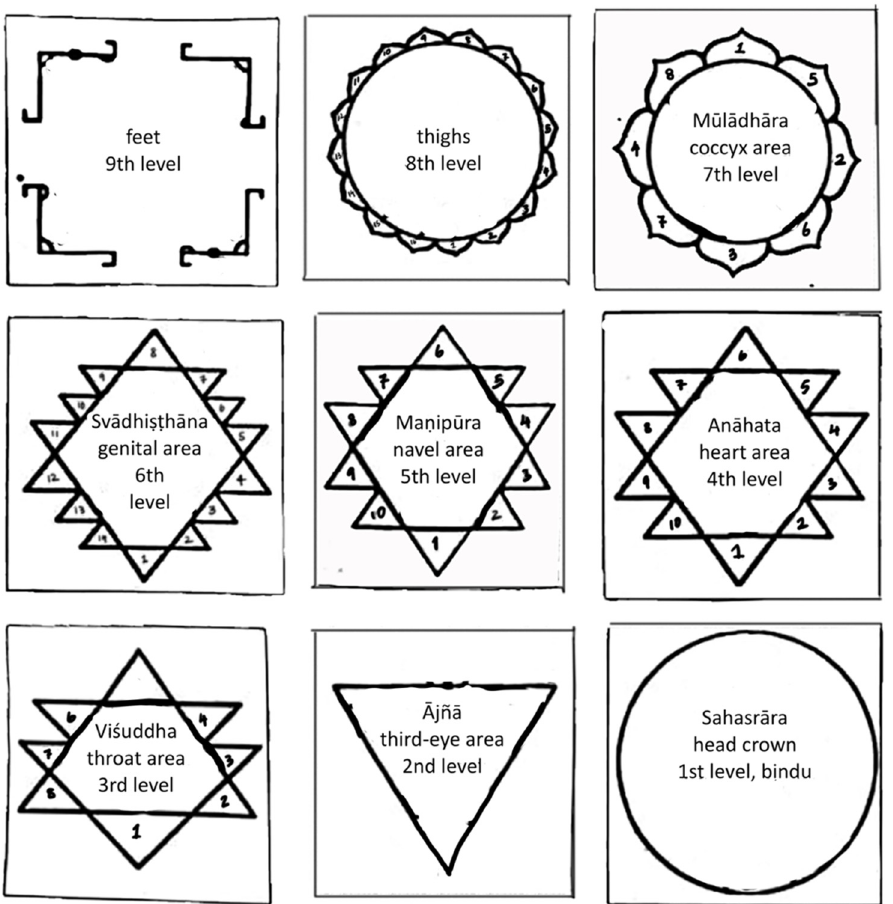
Figure 1. Nine levels of the Ś r ī cakra and corresponding area in Dev ī ’s and practitioners’ bodies. Credit: based on material provided in Ś